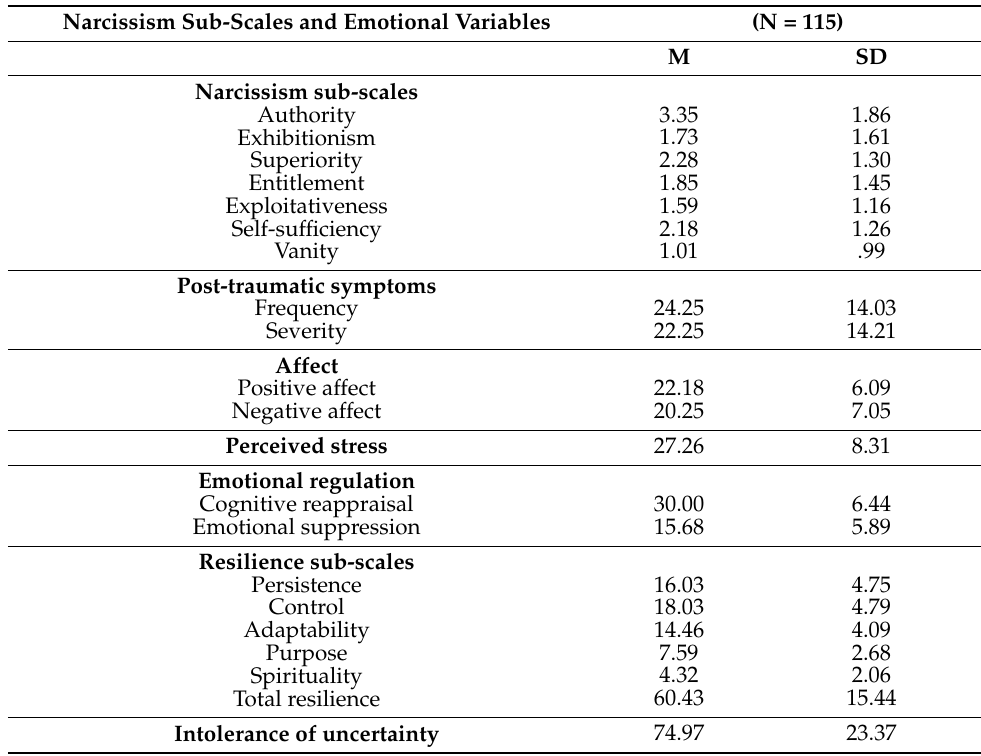
Table 1. Mean (M) and standard deviation (SD) scores of the different narcissism sub-scales and and emotional variables in the present